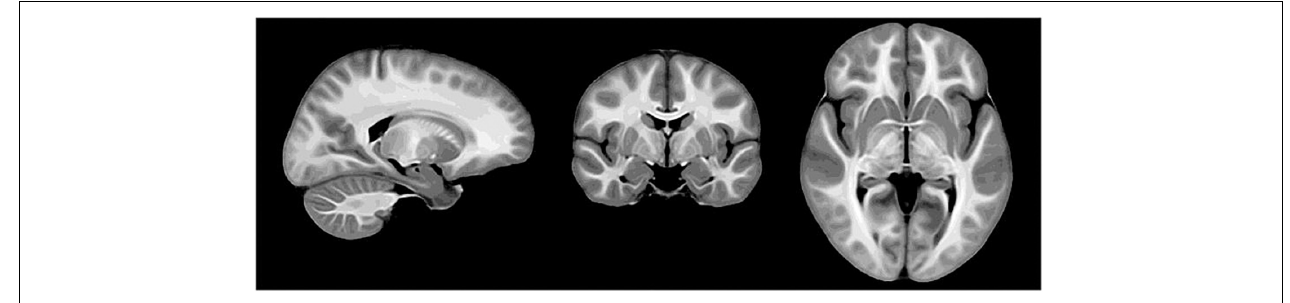
FIGURE 1 | Study-specific template derived from macromolecular proton fraction (MPF) maps of 146 adolescent study subjects (reprinted from Corrigan et al. (2021); free PMC article).